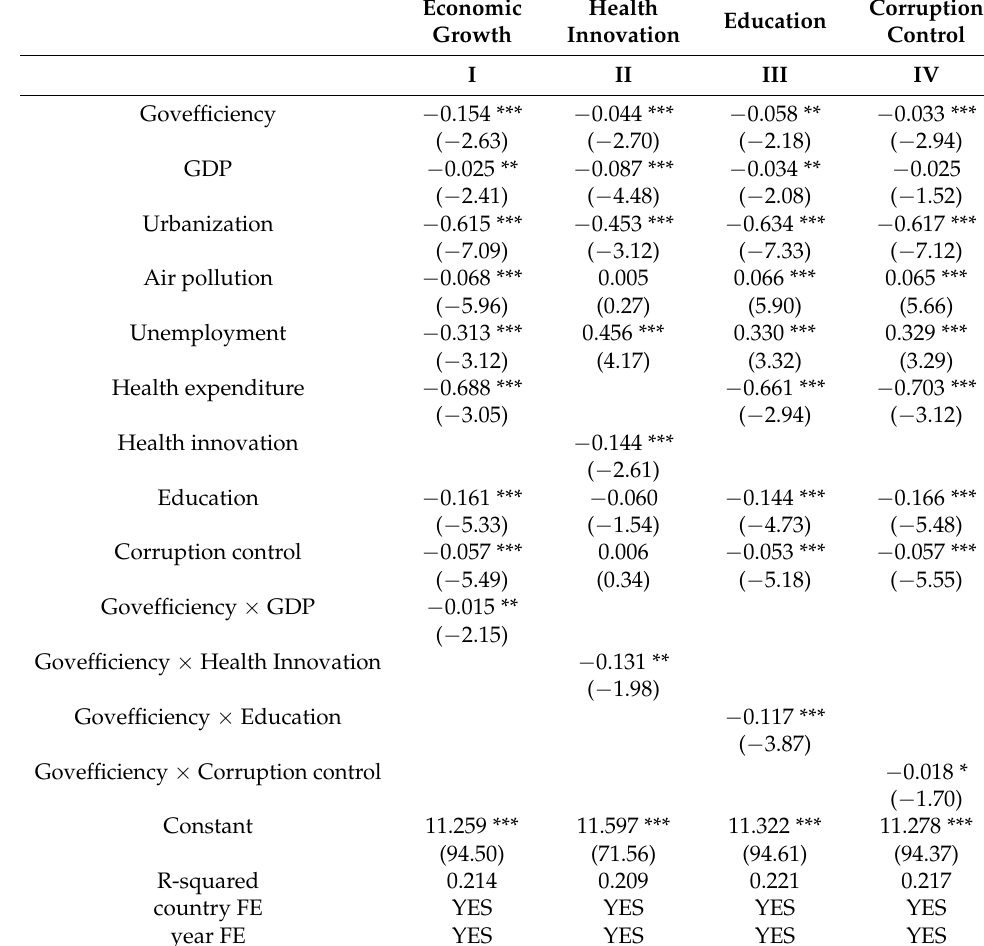
Table 5. Mechanism